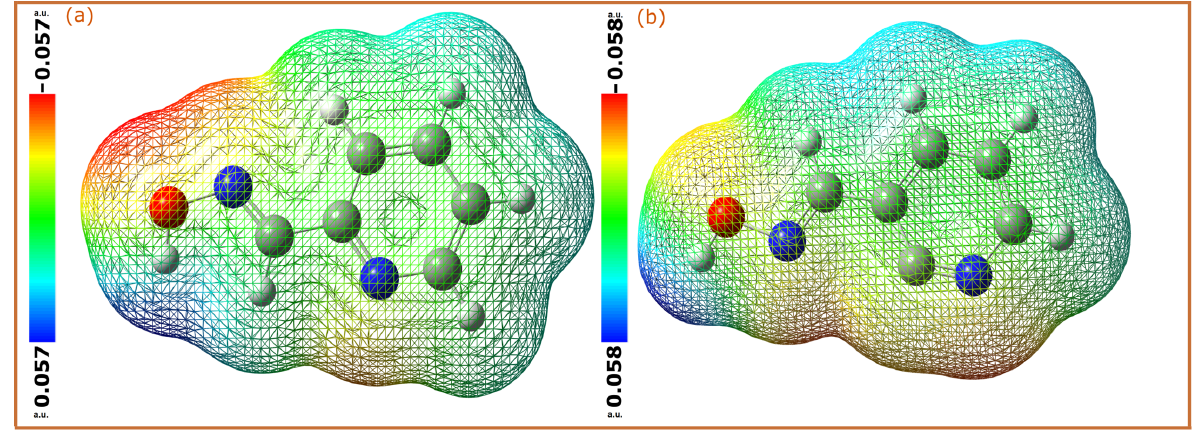
Figure 7. Molecular electrostatic potential of ( a ) 2POH and ( b ) 3POH molecules obtained by DFT/B3LYB method.